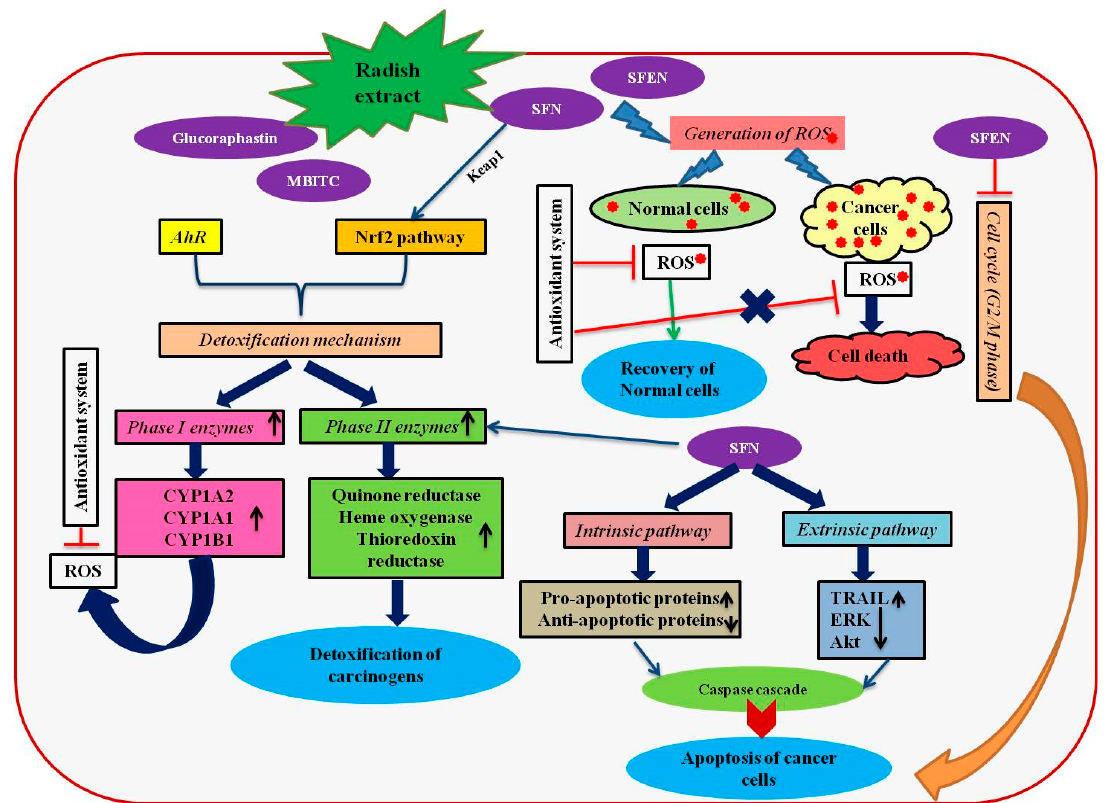
Figure 1. A schematic representation of anticancer mechanisms induced by the bioactive compounds present in radish extracts. The figure has been conceived based on the interpretation of the literatures cited in section (4). AhR, aryl hydrocarbon receptor; Akt, alpha serine-threonine protein kinase; CYP, cytochrome P450; ERK, extracellular signal-regulated kinase;